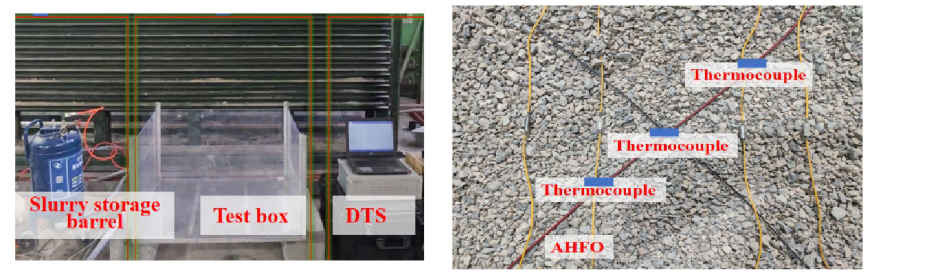
Figure 3. Grouting simulation system.